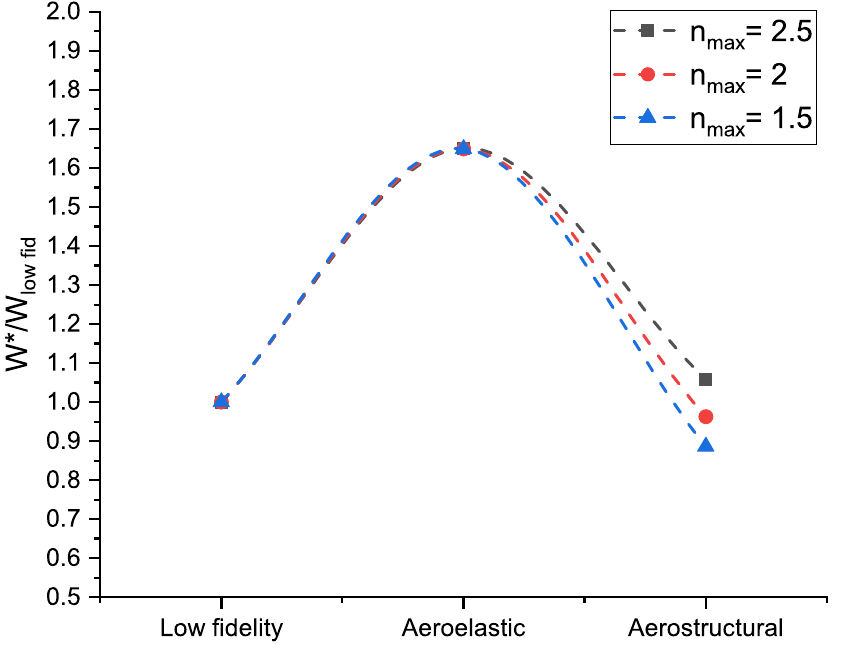
Figure 10. W w variation for backward-swept